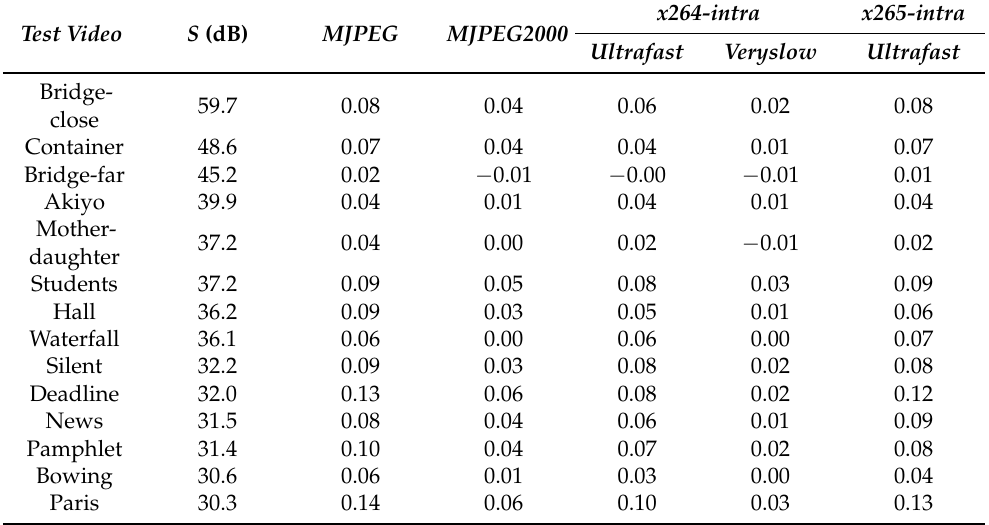
Table 7. BD-SSIM provided by CS-JPEG compared with different intra-frame